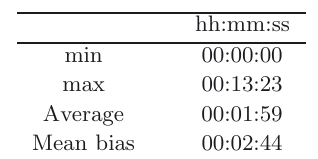
Fig. 5. Example of location of the PIR motion detector. Table 1. Balance differences between PIR and BOMAS.